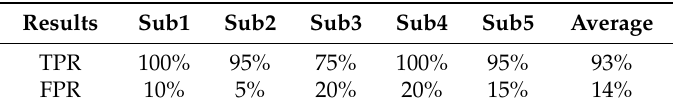
Table 3. True positive rate (TPR) and false positive rate (FPR) of steady-state visually evoked potential (SSVEP) detection results at Oz.